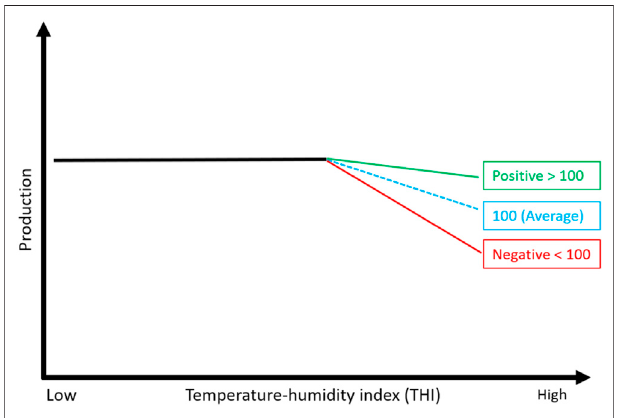
FIGURE 7 | Representation of heat tolerance breeding values (HT GEBVs) that were released to the Australian dairy industry in 2017 (Nguyen et al., 2017). The daughters of a bull with HT GEBV above average (positive) are expected to be more tolerant than the daughters of an average bull and vice versa for bulls with below-average HT